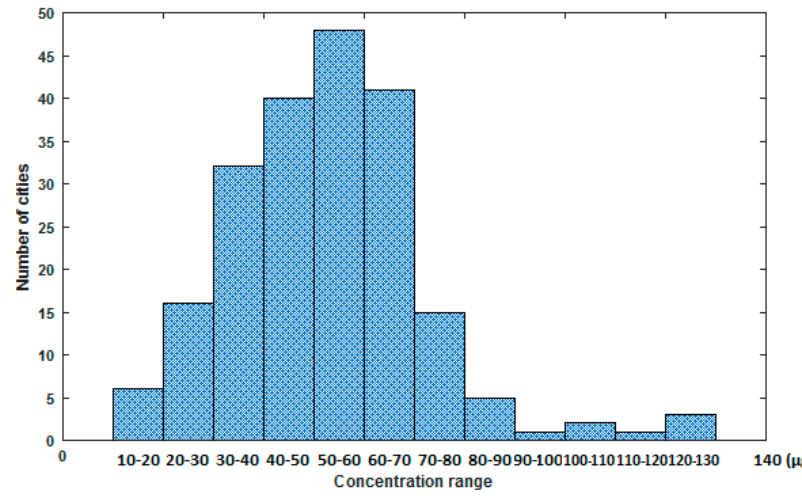
Figure 2. Histogram distribution of PM 2.5 concentration [7] .